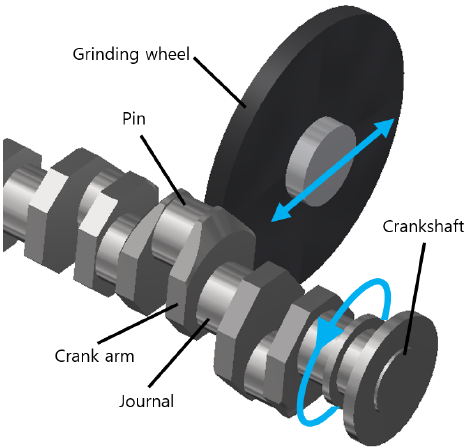
Figure 1. Non-circular grinding.